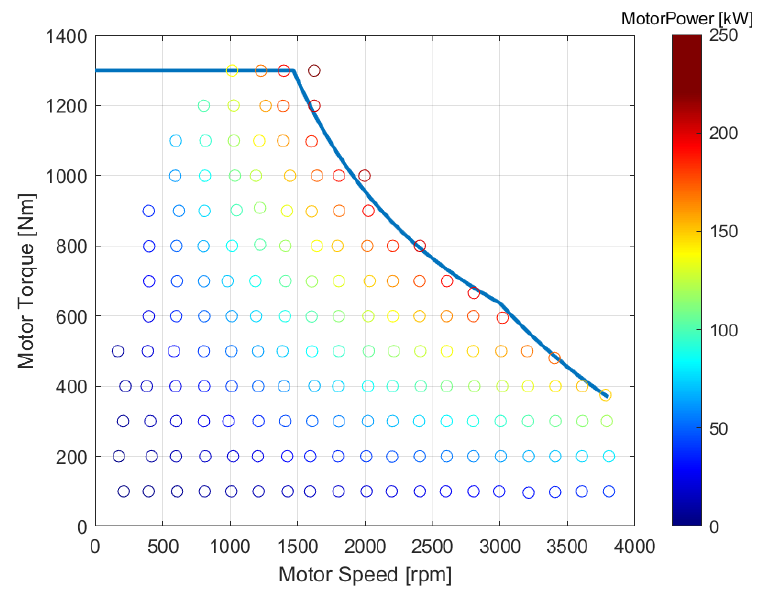
Figure 9. Motor torque and power versus motor speed.